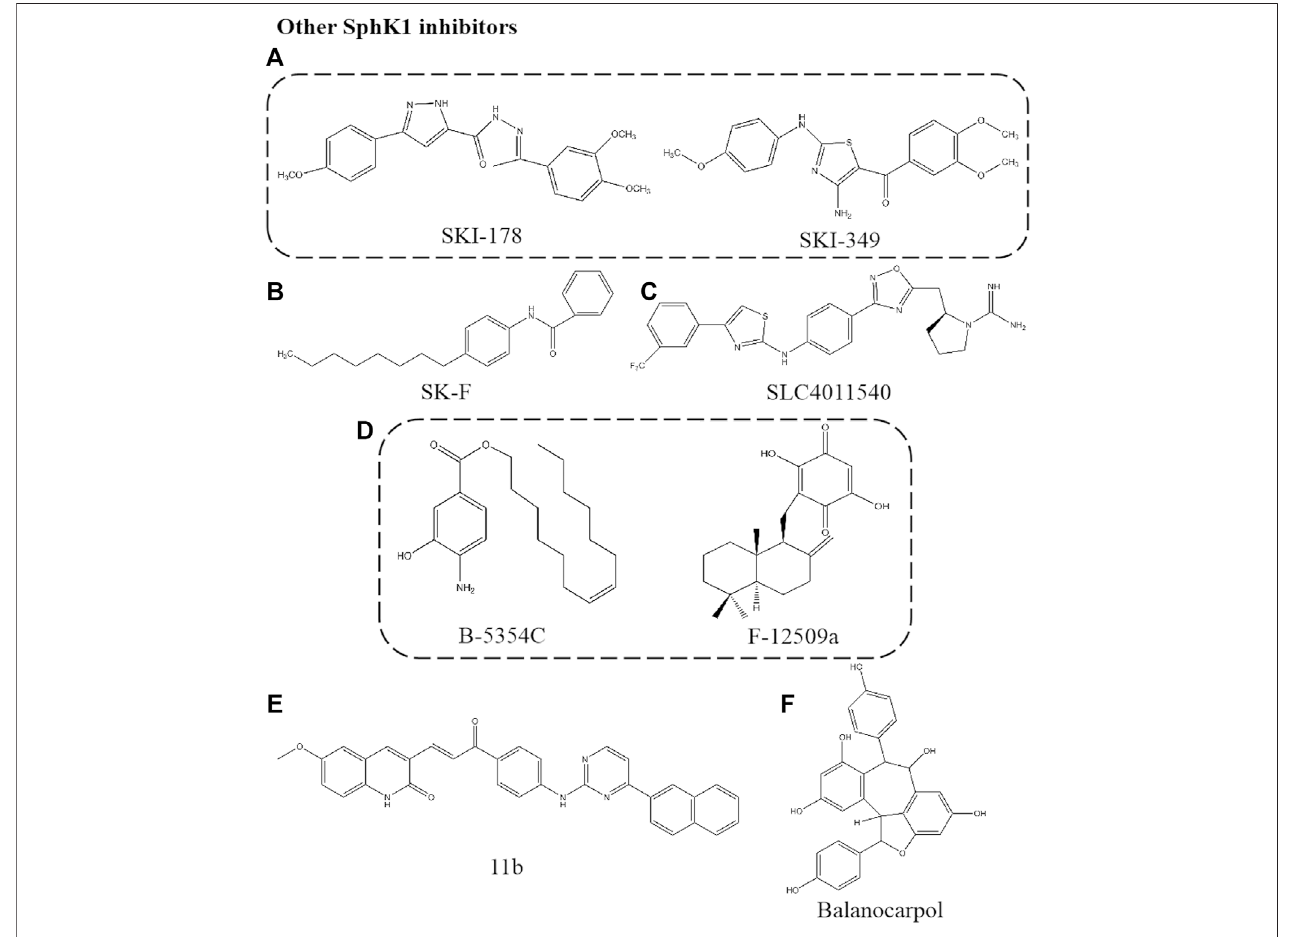
FIGURE 5 | Structures of other SphK1